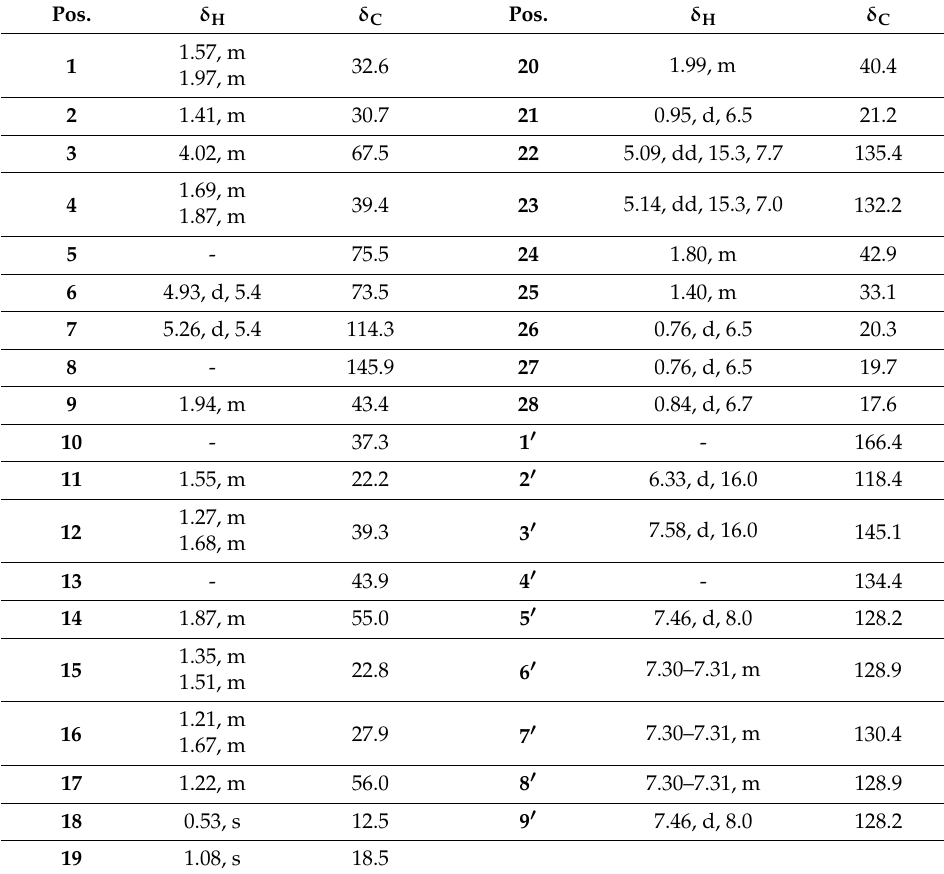
Table 1. 1 H (600 MHz) and 13 C-NMR (150 MHz) spectroscopic data of compound 6 (CDCl 3 , δ (ppm), J